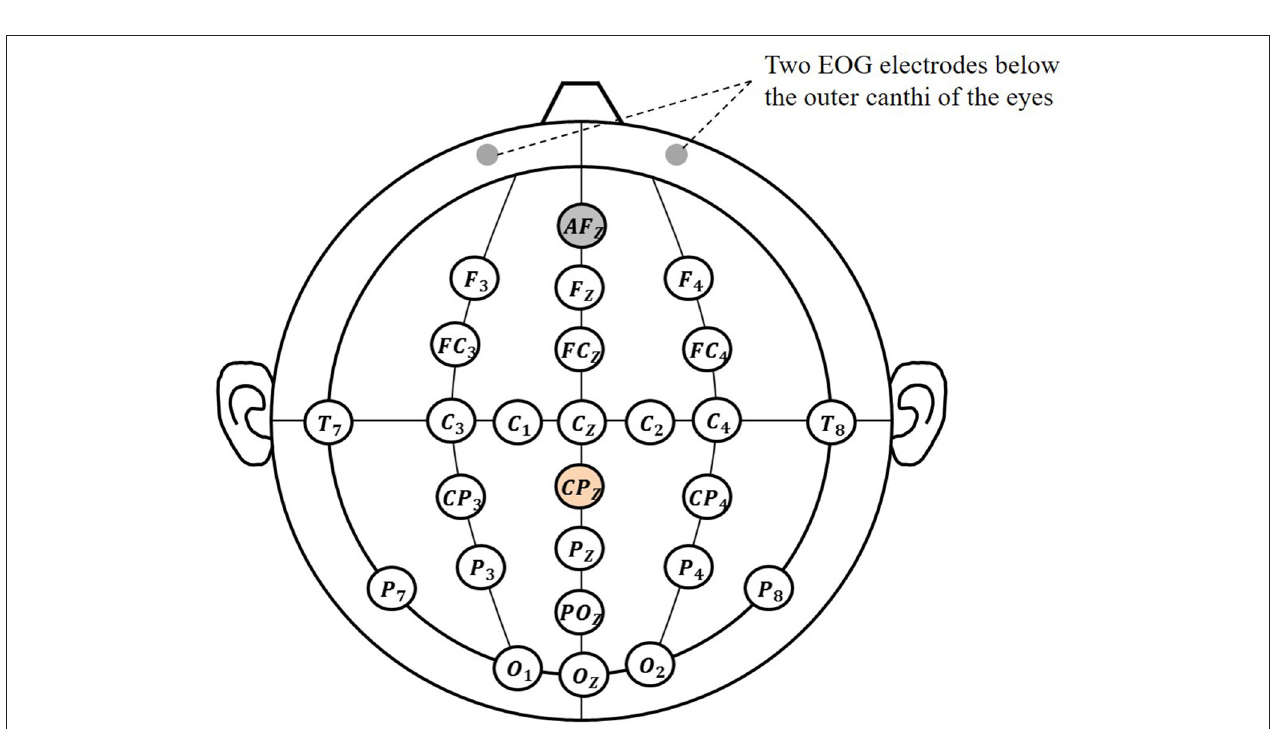
FIGURE 1 | Experimental protocol. (A) Timeline of experiment setup. Note that time 4s refers to the Go-Cue, and time 4.5s is the actual movement onset. (B) Illustration of both hand movement directions. Note that “F” and “B” refer to the movement of left-hand in the forward or backward direction, respectively, and “R” and “L” refer to the movement of right-hand in the right and left direction, respectively.